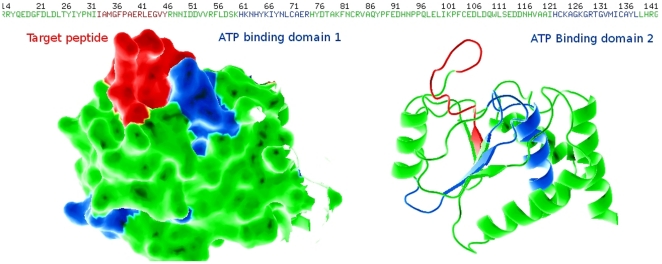
Scheme of PTEN structure showing the selected PTEN peptide and the ATP-binding regions.The figure shows the regions of interest: the amino domain of the PTEN protein surface and the backbone. The peptide surface exposed on the PTP domain is shown in the peptide sequence (detailed in the upper left hand corner). The ATP binding regions are shown in blue, and the target peptide is shown in red as shown in the upper sequence. Note that the ATP binding peptides correspond to the internal portion of the phosphatase structure. The graphic was developed using the PyMol program.